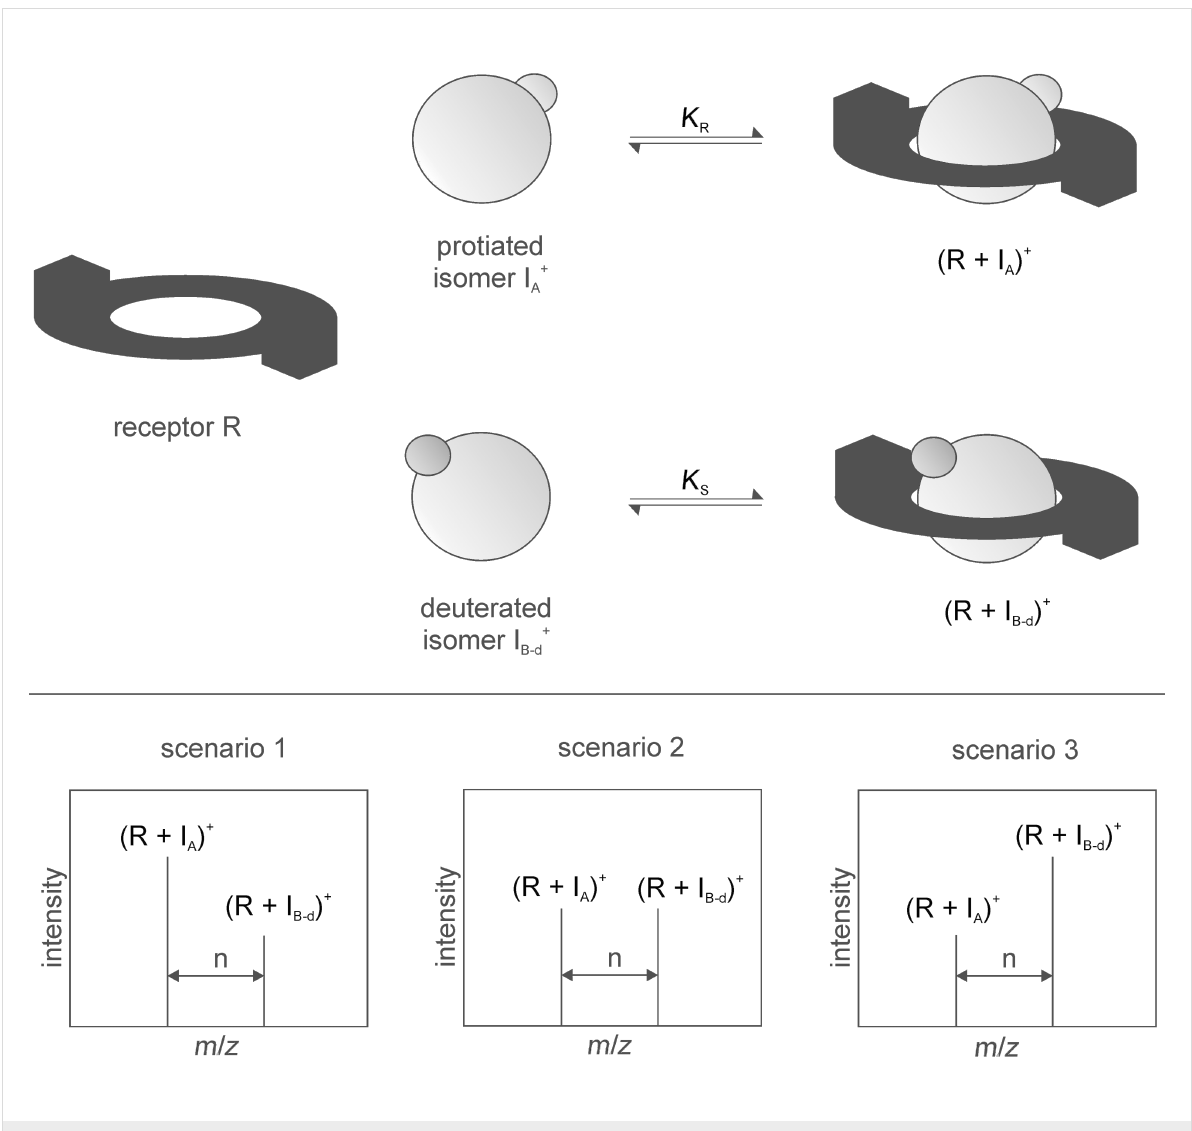
cult to assign the signals to the individual host–guest complexes and the analysis might be additionally hindered or even be impossible due to severe signal